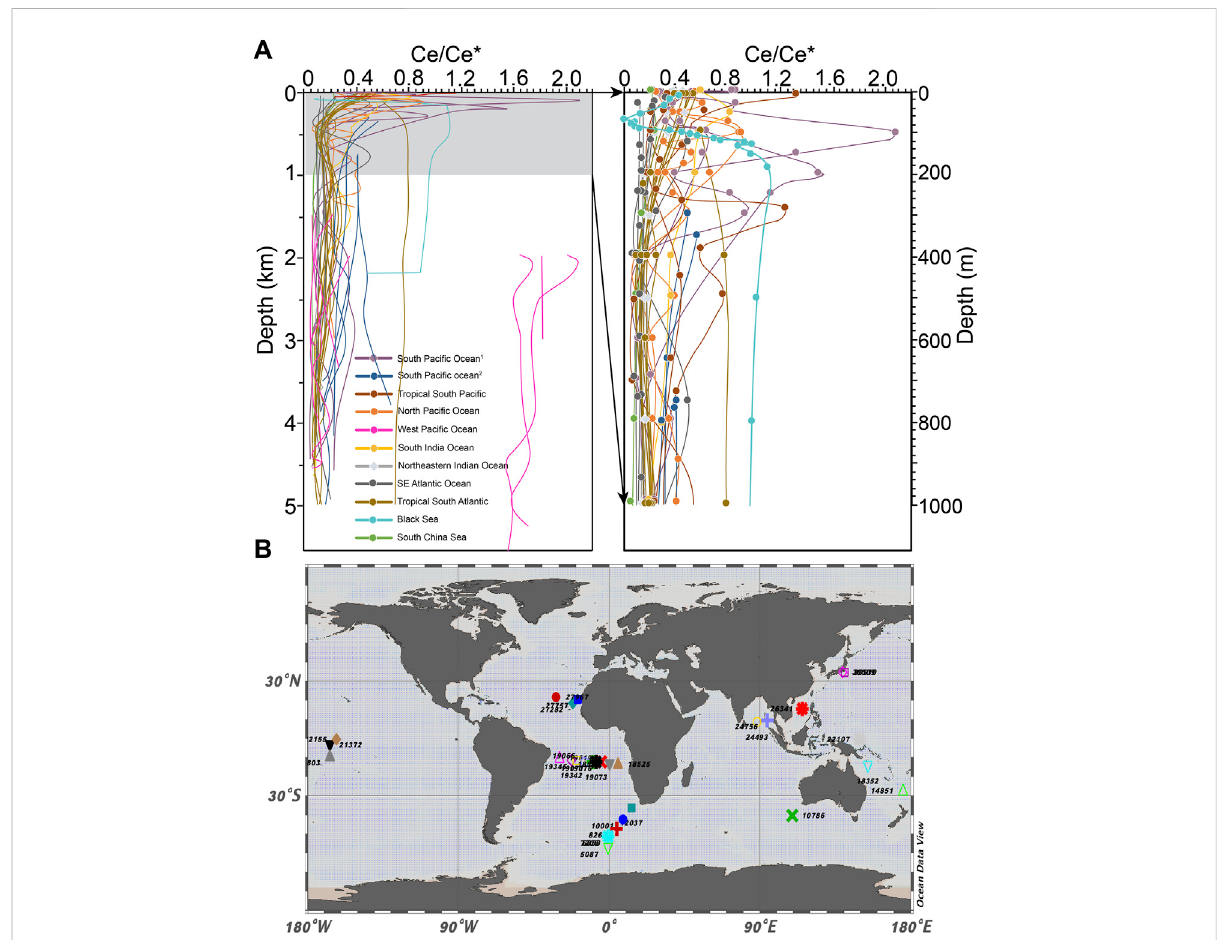
(Table 2), K H stands for the equilibrium constant of association of H 2 CO 3